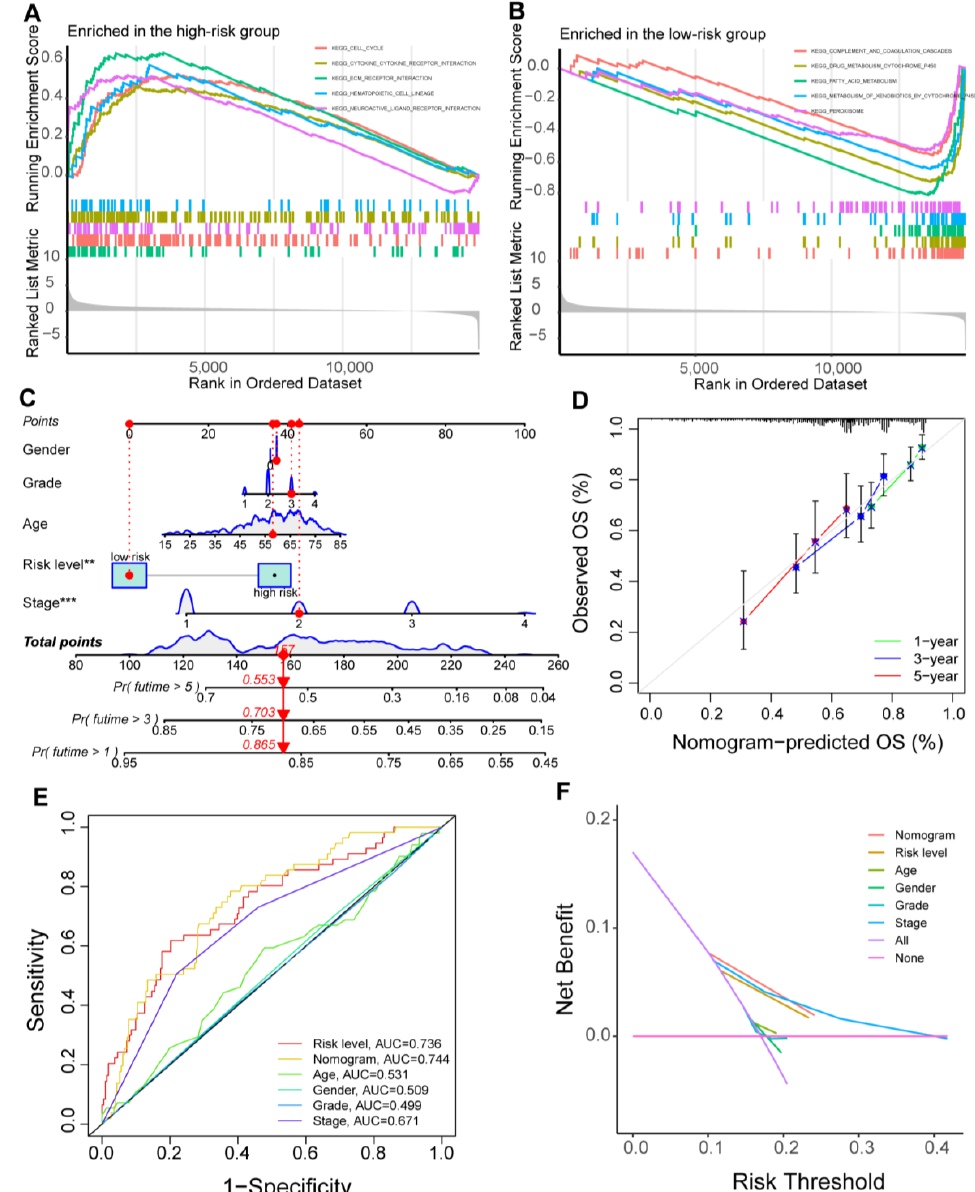
Figure 4. Correlation analysis between cluster types and the prognostic signature, and the construc- tion of a nomogram. ( A , B ) GSEA analysis identified key pathways in high-risk and low-risk groups. ( C ) A nomogram for prediction of 1-, 3-, and 5-year overall survival in HCC patients. ( D ) The cali- bration curves of the nomogram predict the probability of 1-, 2-, and 3-year OS. ( E ) ROC curves of the nomogram compared with other clinical parameters. ( F ) Clinical benefit of the nomogram eval- uated by decision curve analysis. Gene Set Enrichment Analysis, GSEA; Overall survival, OS; Re- ceiver operating characteristic, ROC. **, p < 0.01; ***. p < 0.001. A nomogram was established to assess the 1-, 3-, and 5-year OS (Figure 4C), and the calibration curve revealed the nomogram’s ideal consistency for predicting 1-, 3-, and 5-